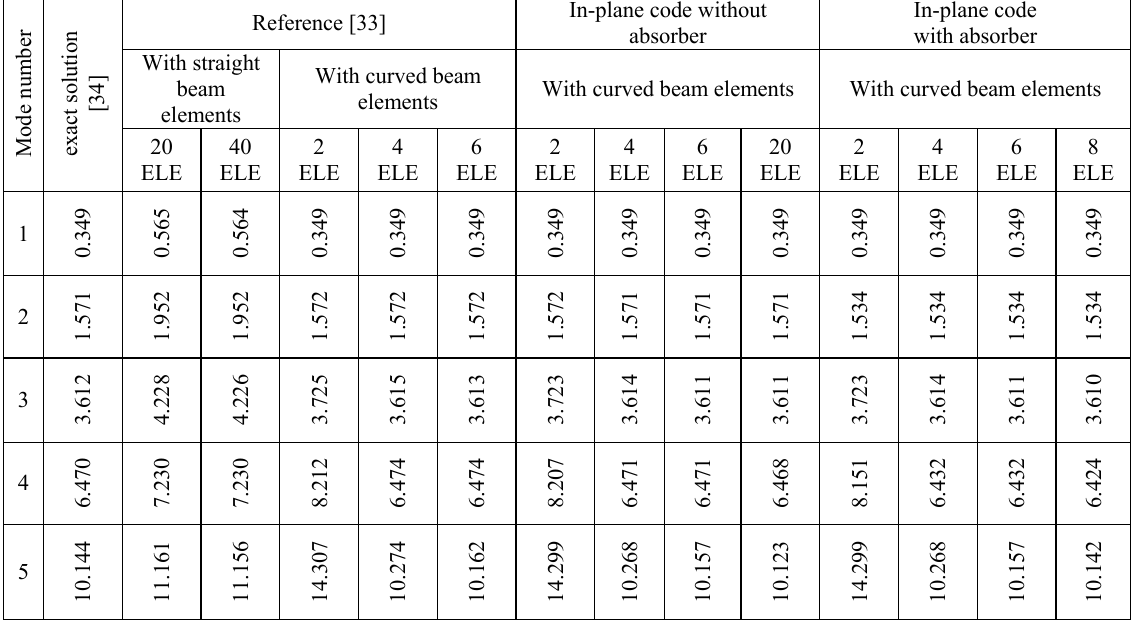
Table 2. Natural frequencies of curved beams (Hz) with S-S boundary conditions ( Left Right v = v = 0